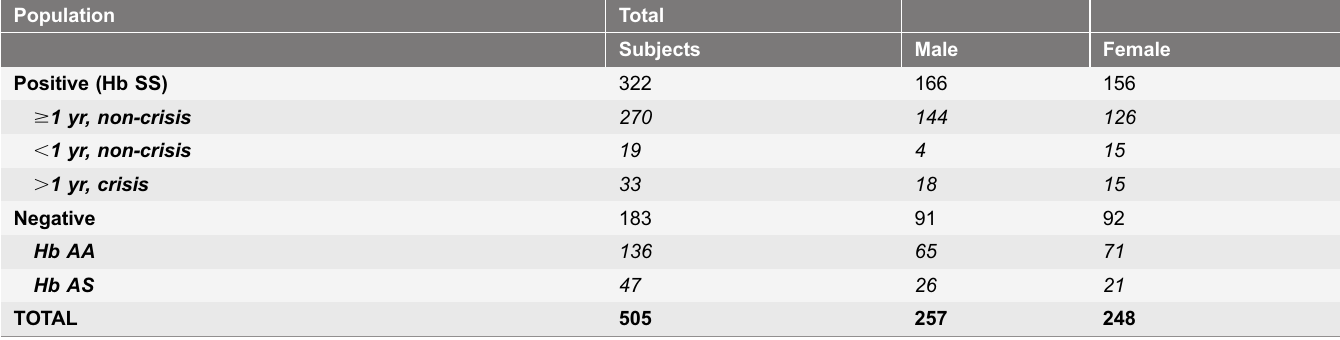
Table 2. Basic Characteristics of the Study